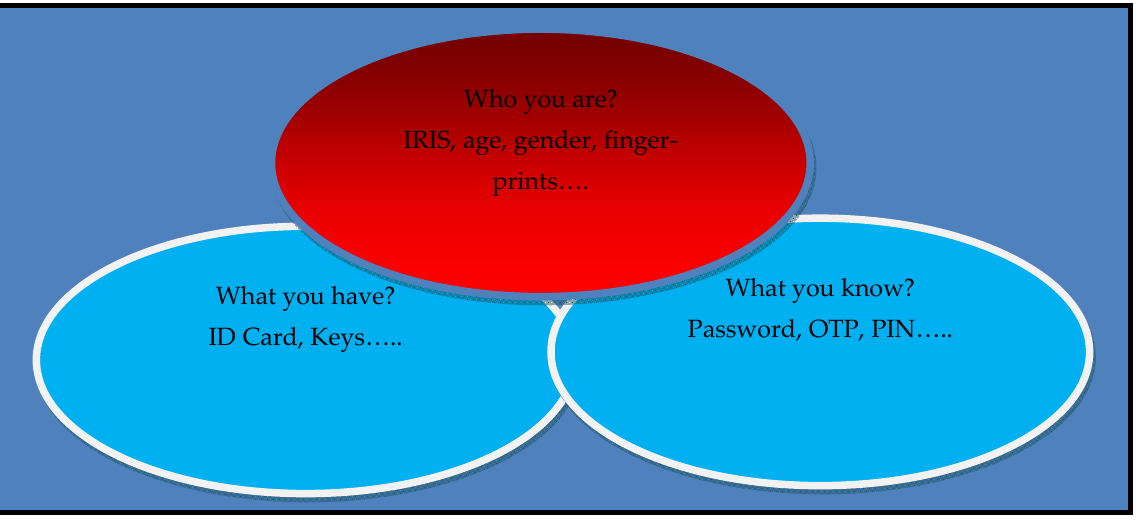
Figure 1. General diagram of Authentication [4].